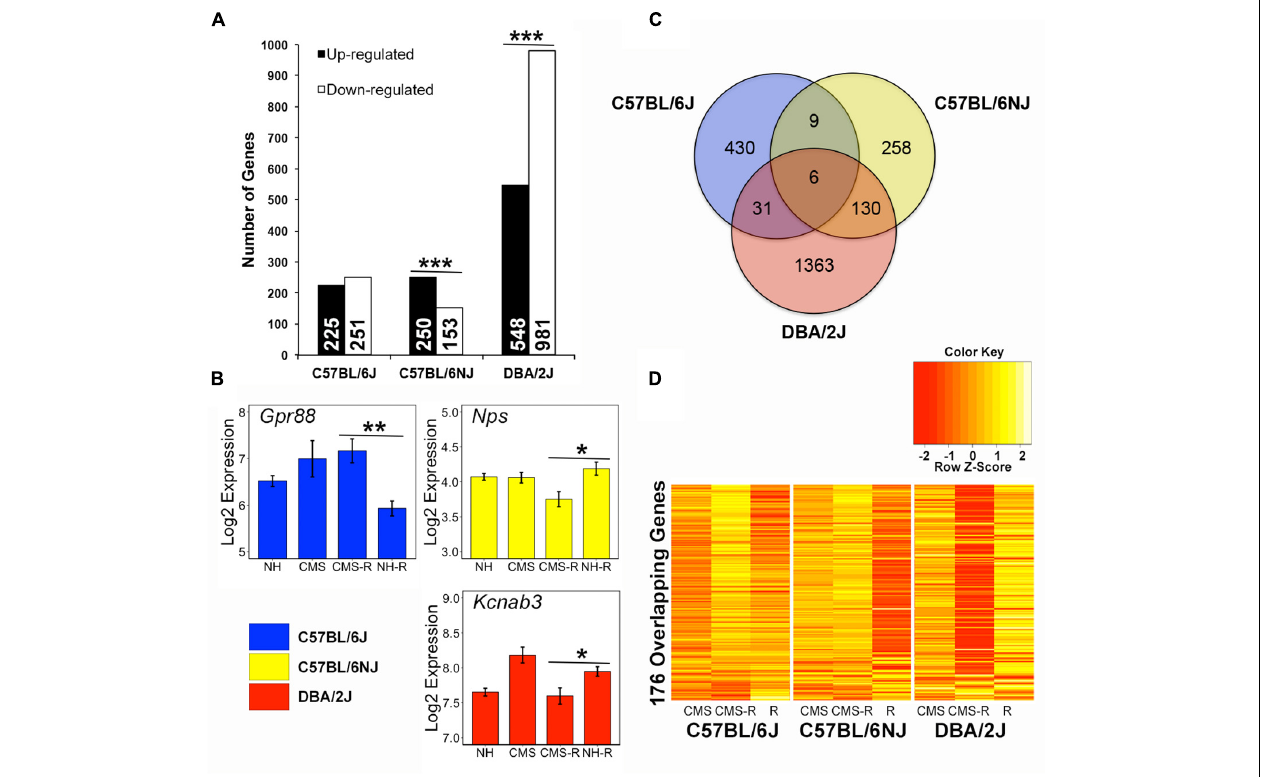
FIGURE 3 | Strain differences in the hippocampal transcriptional response to stress. (A) Probe sets (transcripts) whose expression significantly ( p < 0.05) fit stress up-regulated or stress down-regulated patterns (prioritized based on significant and greater than 10% fold change difference within strain between CMS-R and NH-R treatments) are categorized by strain and pattern. Chronic stress up-regulated transcripts have higher expression following combined chronic and novel acute stress treatment (CMS-R) compared to novel (NH-R) acute stress. Stress down-regulated transcripts have lower expression in the CMS-R treatment group compared to the NH-R treatment group. The N substrain shows a significantly higher number of transcripts up-regulated following stress compared to down-regulated transcripts. In contrast, the D strain has a significantly more transcripts whose expression is decreased in response to a novel acute stressor following chronic stress. No difference is observed for the B substrain. Significance determined using the Chi-Square test for independence. (B) Representative stress sensitive transcripts unique to B (blue), N (yellow), or D (red) are shown. Gpr88 expression is up-regulated by acute stress following chronic stress exposure in B whereas Nps and Kcnab3 expression is down-regulated by chronic stress in the N and D strain, respectively. Gpr88 is an orphan G protein-coupled receptor involved in glutamatergic and GABAergic signaling that may have a role in anxiety and learning and memory (Alavi et al., 2017) and has been previously identified as a chronic stress modulated gene in rodent hippocampus (Ubaldi et al., 2015). NPS encodes the stress sensitive neuropeptide S, which has been associated with regulation of feeding, fear response, and addiction-related traits (Schank et al., 2012). Kcnab3 encodes a potassium voltage-gated channel subunit that is correlated with cognitive performance under chronic stress (Jung et al., 2017) in the BXD population derived from the B and D strains. (C) Comparison of strain specific expression among 2,227 probe sets showing up- or down-regulated expression following exposure to stress reveals strain overlap between 176 probe sets detected in two or more strains. (D) Hierarchical clustering of the 176 overlapping stress sensitive genes reveals contrasting expression between B and N substrains and the D strain. ∗ p < 0.05; ∗∗ p < 0.01; ∗∗∗ p <